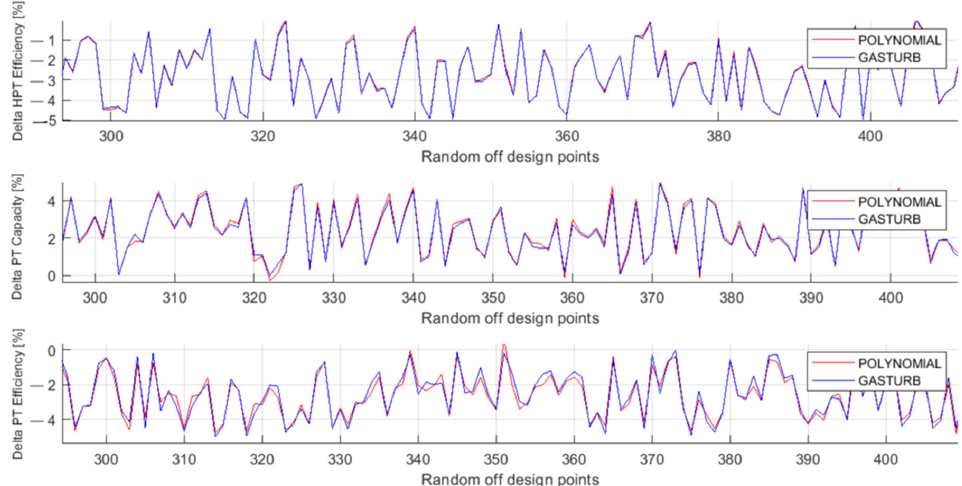
Figure 5. Fault parameters Δ HPTE, Δ PTC, and Δ PTE, true and simulated by polynomials (Testing set).